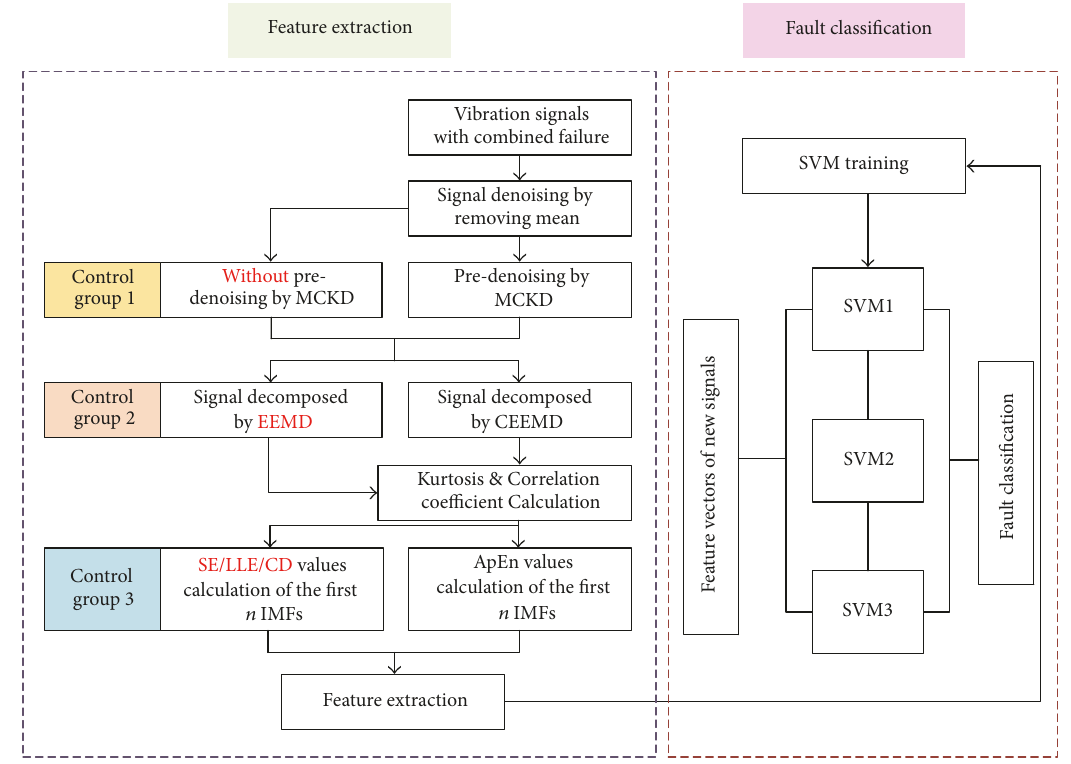
Figure 1: Flow chart of the proposed